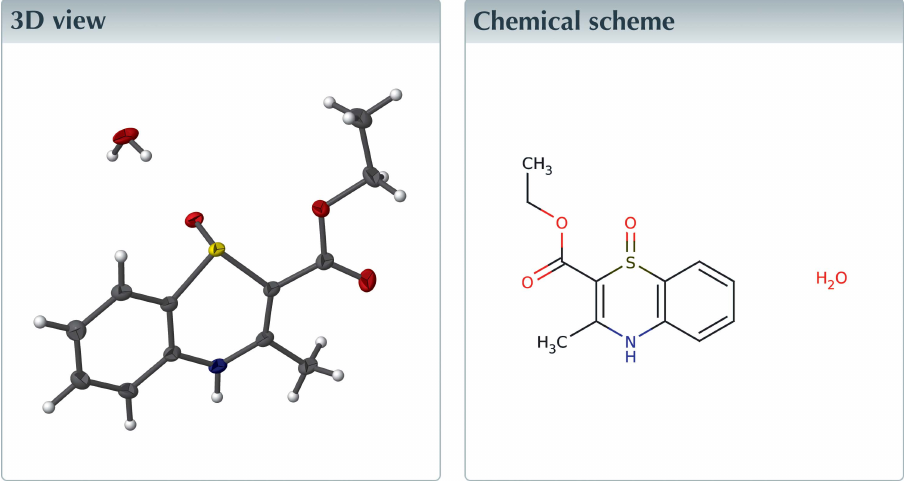
(Table 1) generate generate chains two molecules thick extending along the a